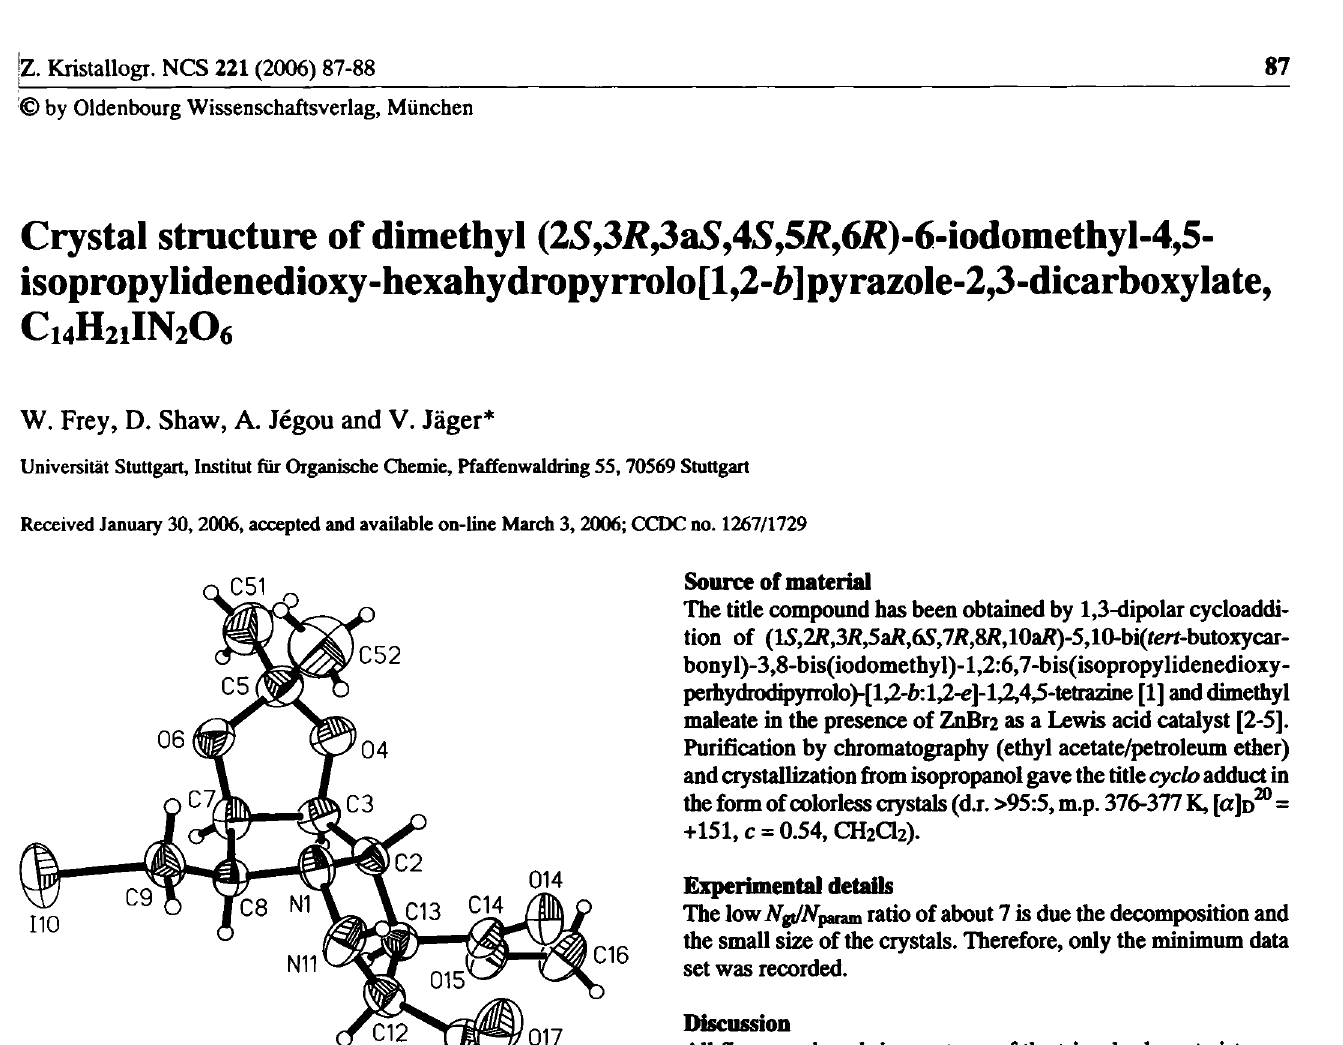
Table 1. Data collection and handling.